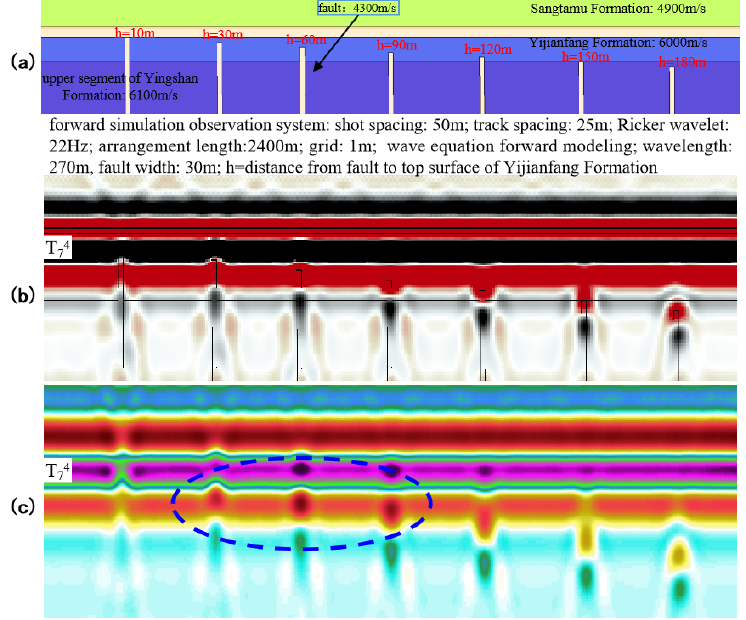
Figure 10. Seismic response characteristics at different distances between the top surface of the fault controlled fracture cavernous reservoir and the top surface of the Yijianfang Formation. ( a ) geologic model, different colors represent different strata; ( b ) forward modeling seismic imaging section; ( c ) color display of forward modeling seismic imaging section.